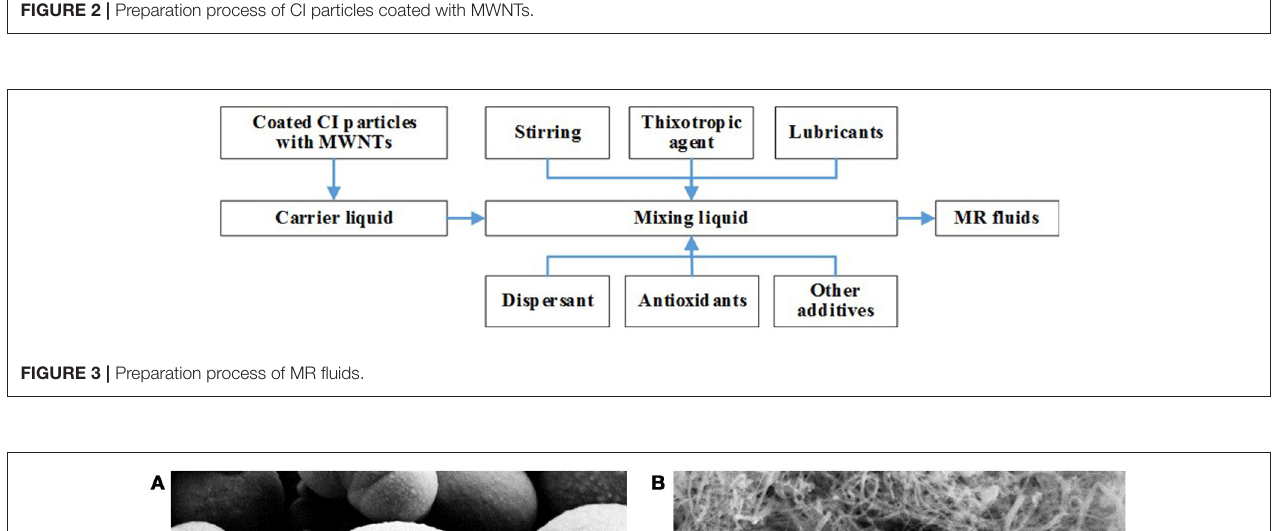
FIGURE 2 | Preparation process of CI particles coated with MWNTs.